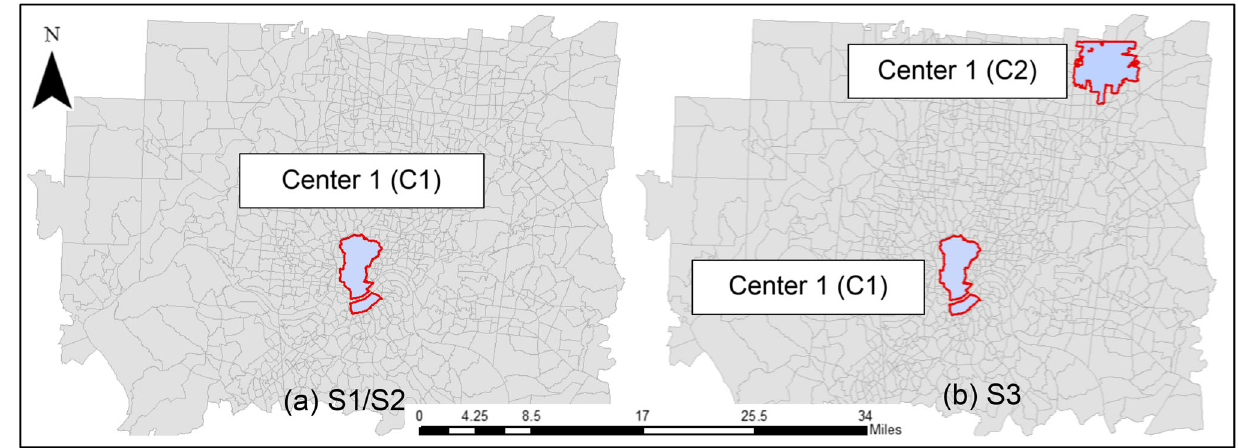
Fig. 4 Incentive boundary of each assumed scenario in the case study